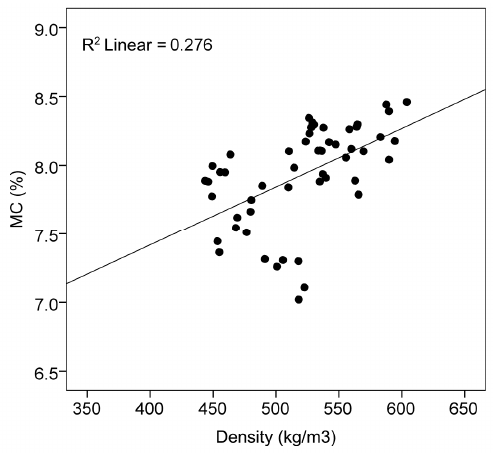
Figure 5. Variation in moisture content and density of P. radiata samples.